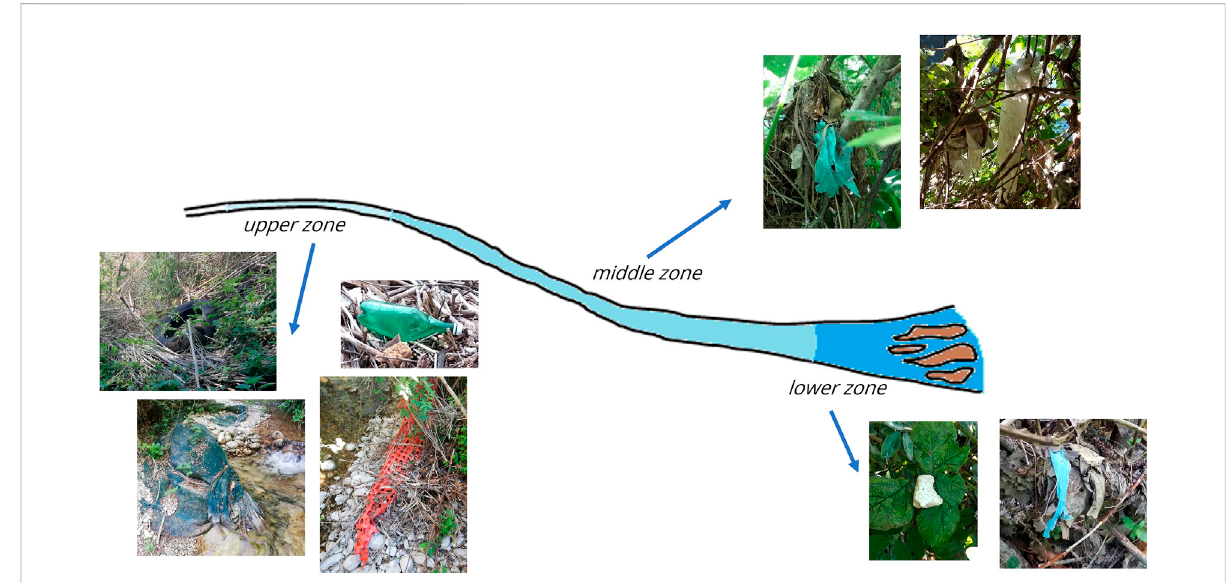
FIGURE 8 Macroplastic fi eld observations (Gallitelli et al., 2022) along watercourses in Latium (Central